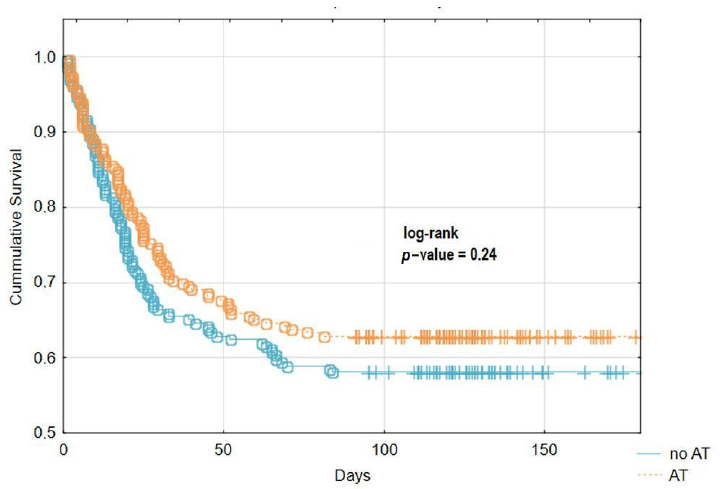
Figure 2. Kaplan–Meier curve showing cumulative 180 days survival stratified for patients with and without AT after PSM.